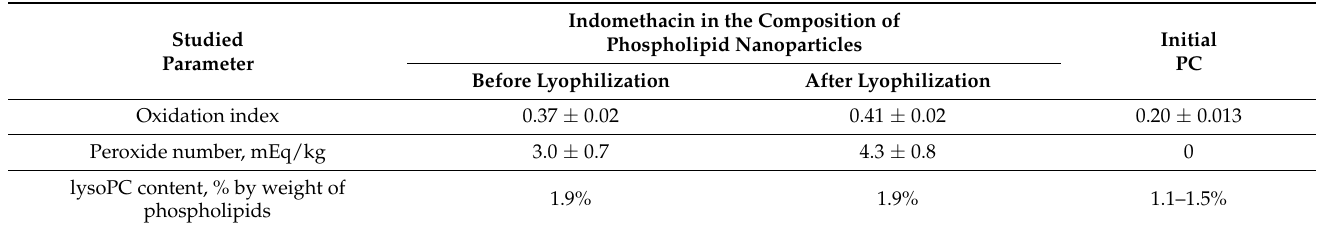
Table 2. Parameters of evaluation of phospholipid oxidation in indomethacin